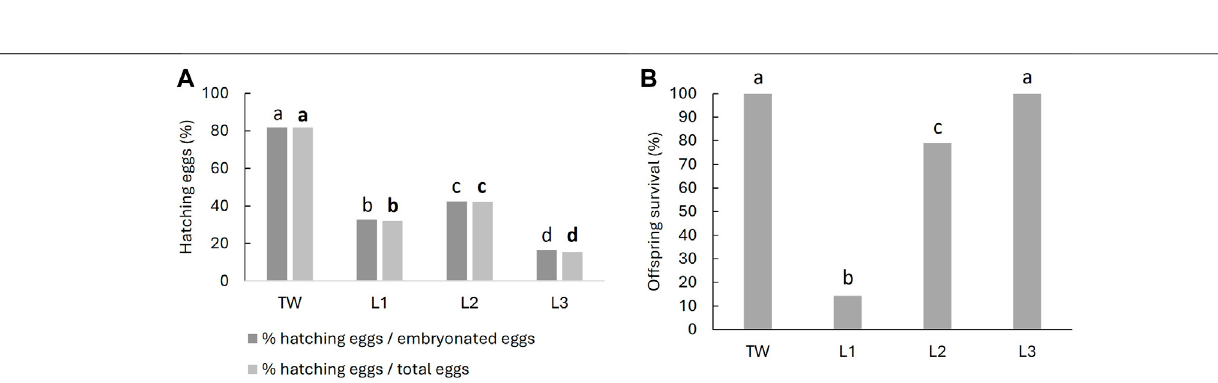
Frontiers in Physiology |